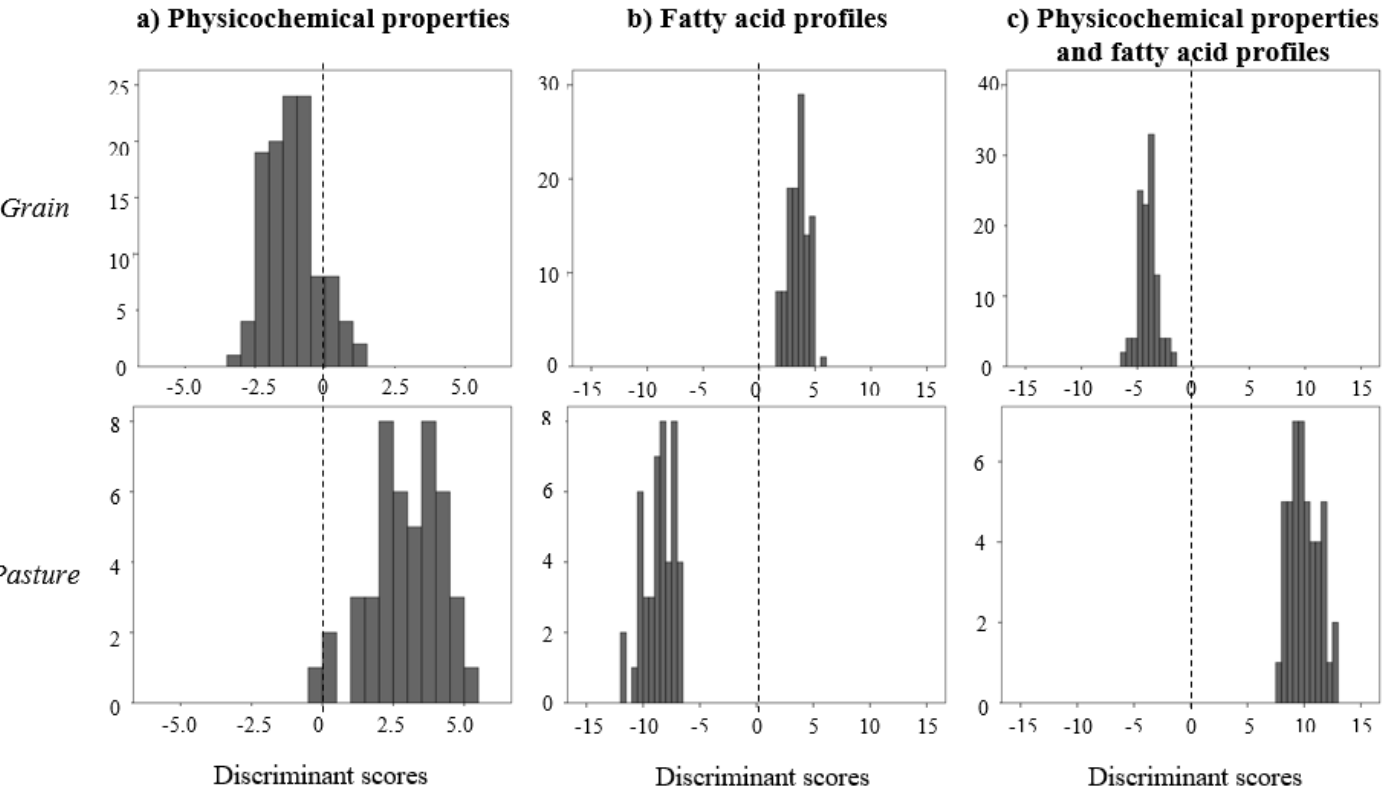
Figure 2. Distribution of discriminant scores in l. thoracis samples from bulls finished on grain or pasture, based on: ( a ) meat physicochemical properties; ( b ) fatty acid profiles; ( c ) physicochemical properties and fatty acid profiles.